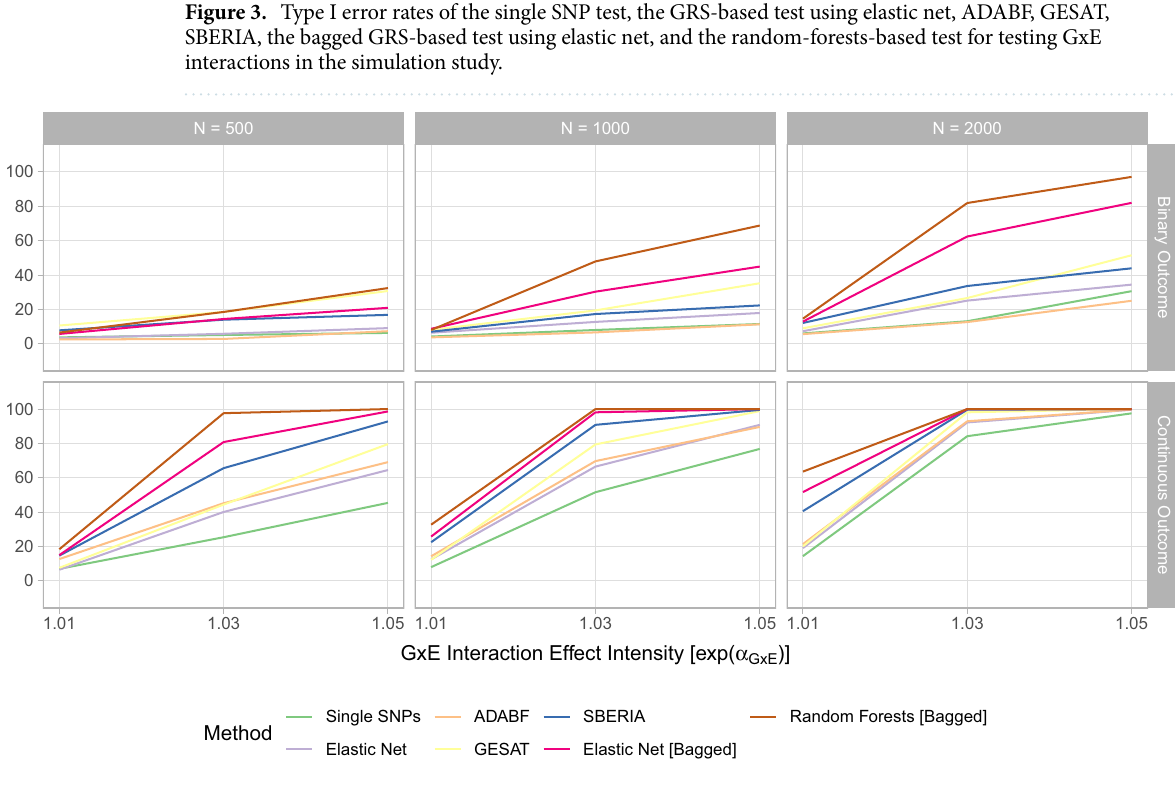
Figure 4. Statistical power of the single SNP test, the GRS-based test using elastic net, ADABF, GESAT, SBERIA, the bagged GRS-based test using elastic net, and the random-forests-based test for testing GxE interactions in the first scenario (see Eq. (4)) of the simulation